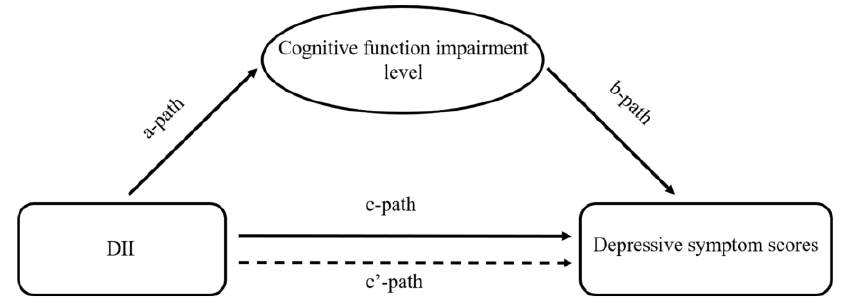
Figure 2. Path diagram of the mediation analysis models.